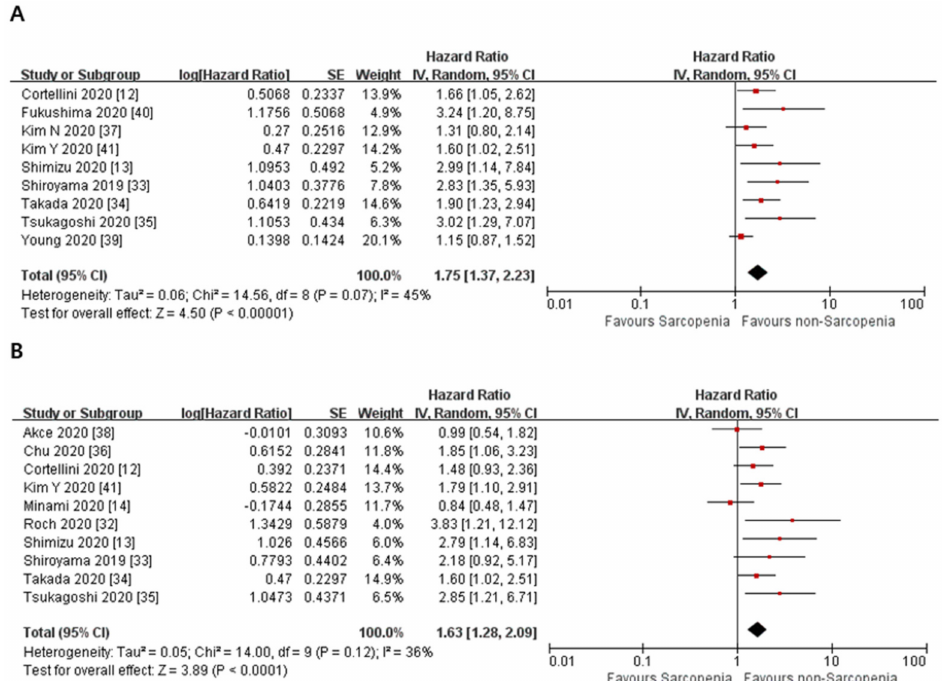
Figure 3. Forest plots of hazard ratios of sarcopenia on progression-free survival in cancer patients treated with immune checkpoint inhibitors. ( A ) Progression-free survival in the univariate analysis. ( B ) Progression-free survival with adjusted